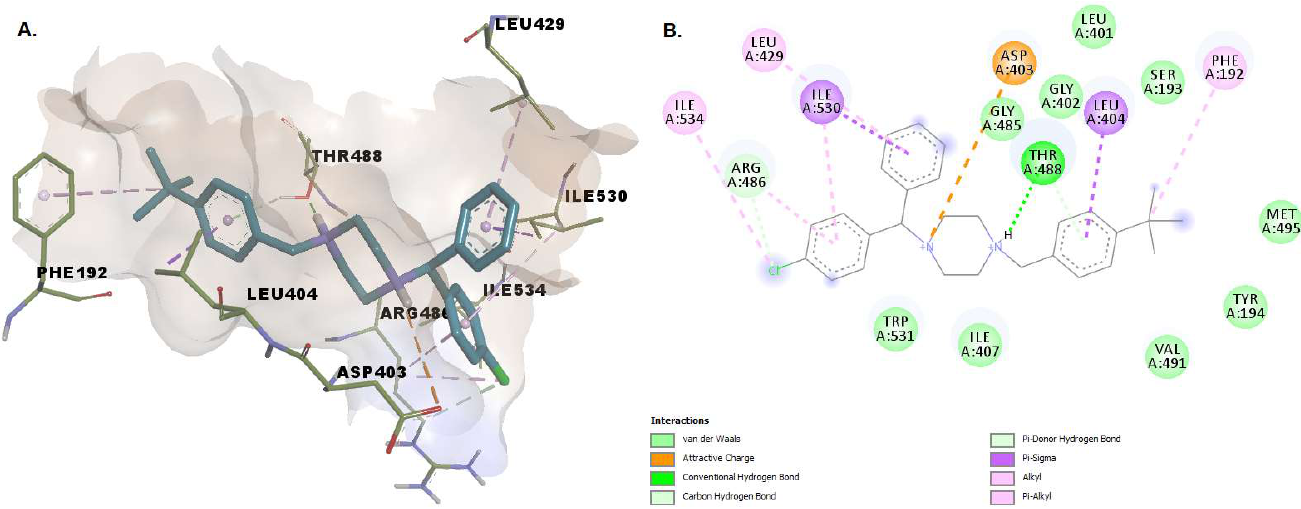
Figure 7. ( A ) 3D binding conformation of buclizine into FAAH binding site; ( B ) 2D diagram of protein-ligand interactions between FAAH and buclizine.